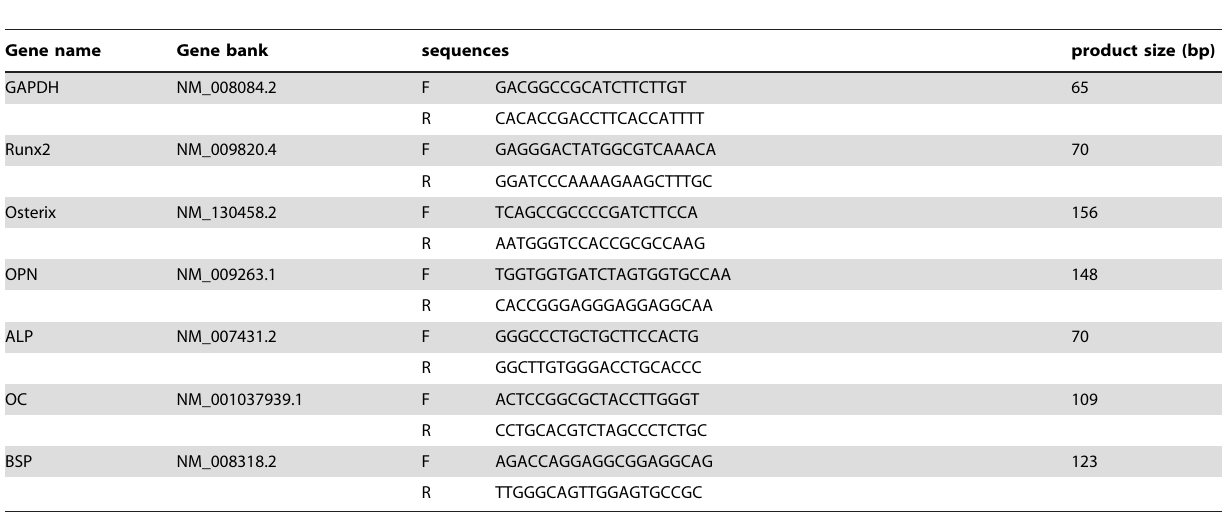
Table 1. The primer sequences used to analyze the expression of bone-specific genes.